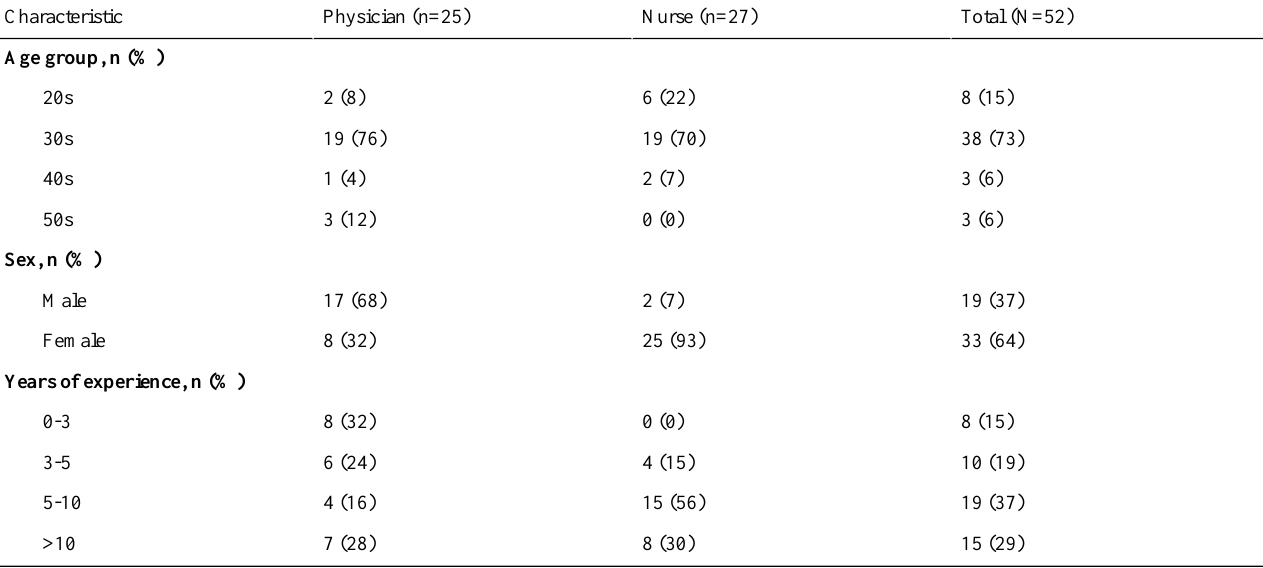
Table 1. Characteristics of participants.